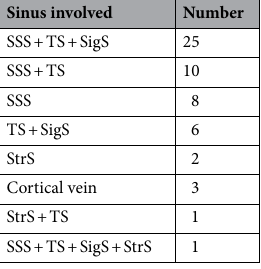
Table 3. Distribution of venous sinus thrombosis of 56 patients. SSS, superior sagittal sinus; TS, transverse sinus; SigS, sigmoid sinus; StrS, straight